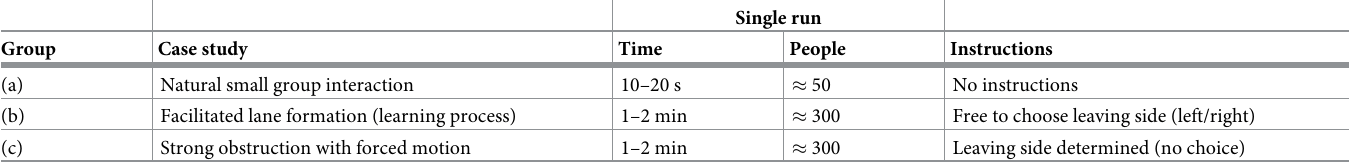
Table 3. Grouping of experimental datasets depending on the type of bidirectional stream considered and the instructions given to participants.